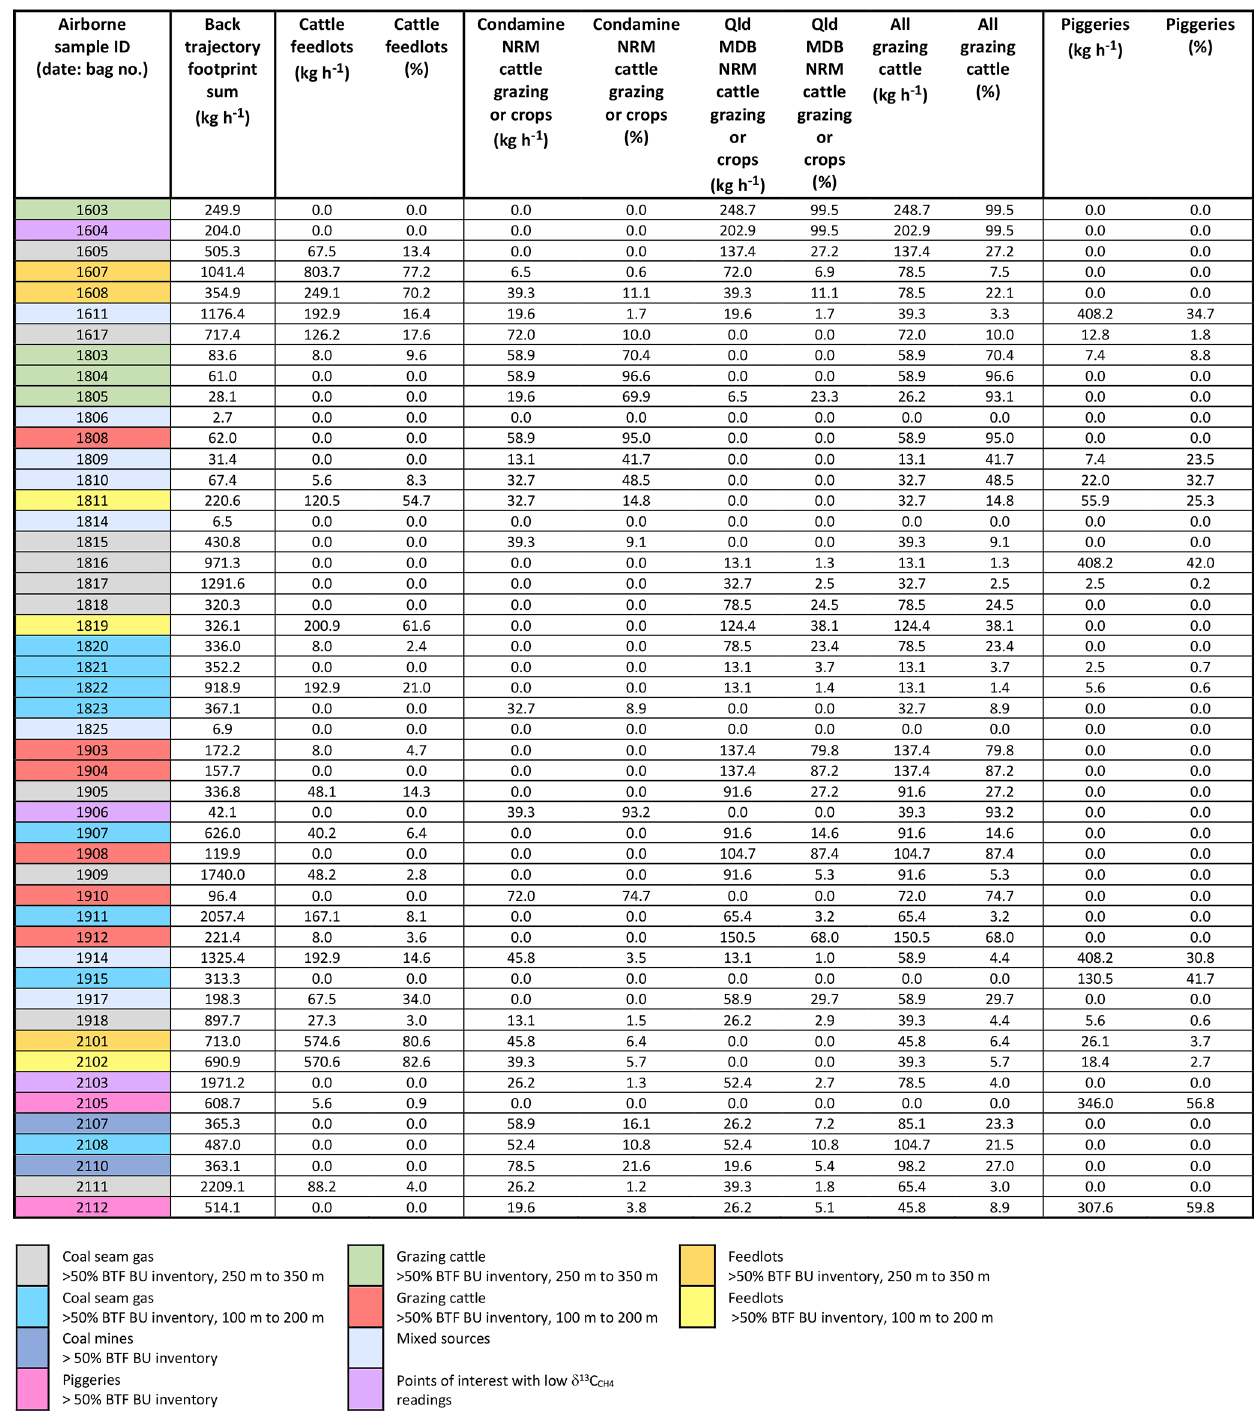
Table A4. In-flight atmospheric air sample location details and UNSW bottom–up inventory CH 4 emissions estimates for major agricultural sources within the 2h back-trajectory footprint (Australian Bureau of Statistics districts: Condamine Natural Resource Management (NRM) area and Queensland Murray–Darling Basin (MDB) Natural Resource Management (NRM)